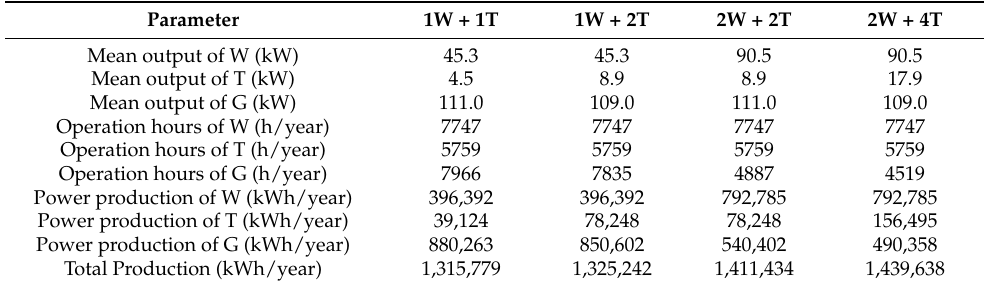
Table 5. Annual mean output, hours of operation, and power production for proposed scenarios at Foveaux site.